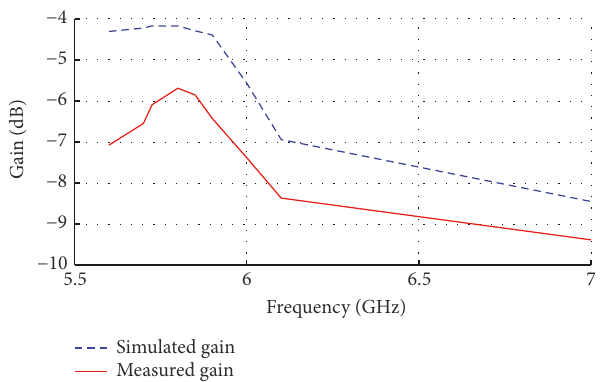
Figure 13: Simulated and measured gain of the proposed antenna.